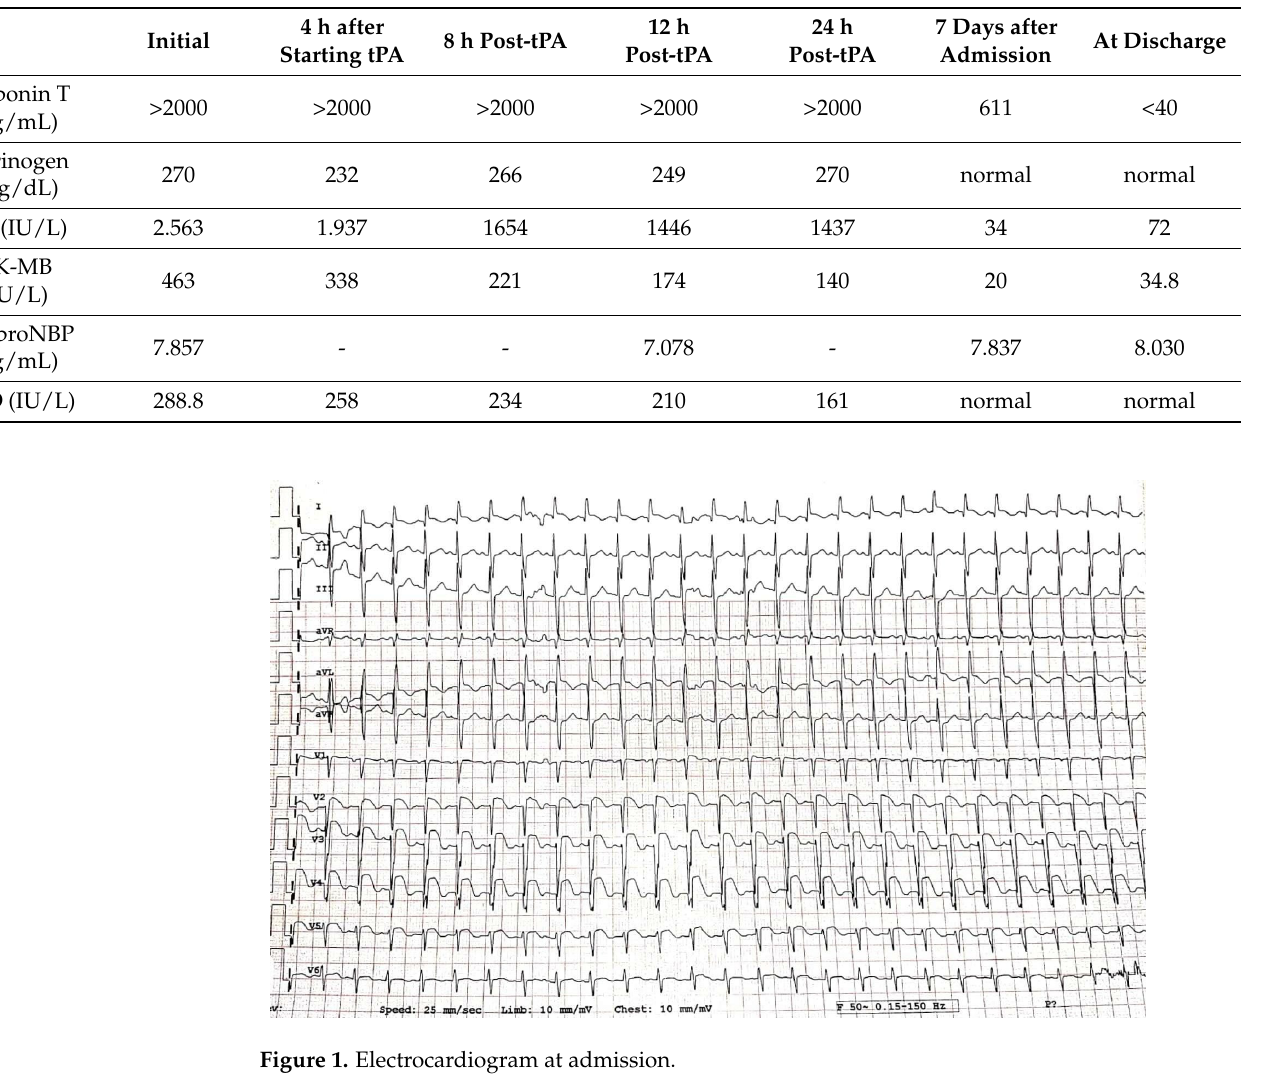
Figure 2. Parasternal long axis. Dilation of a vascular structure into the atrioventricular groove (cir- cumflex artery: white arrow).